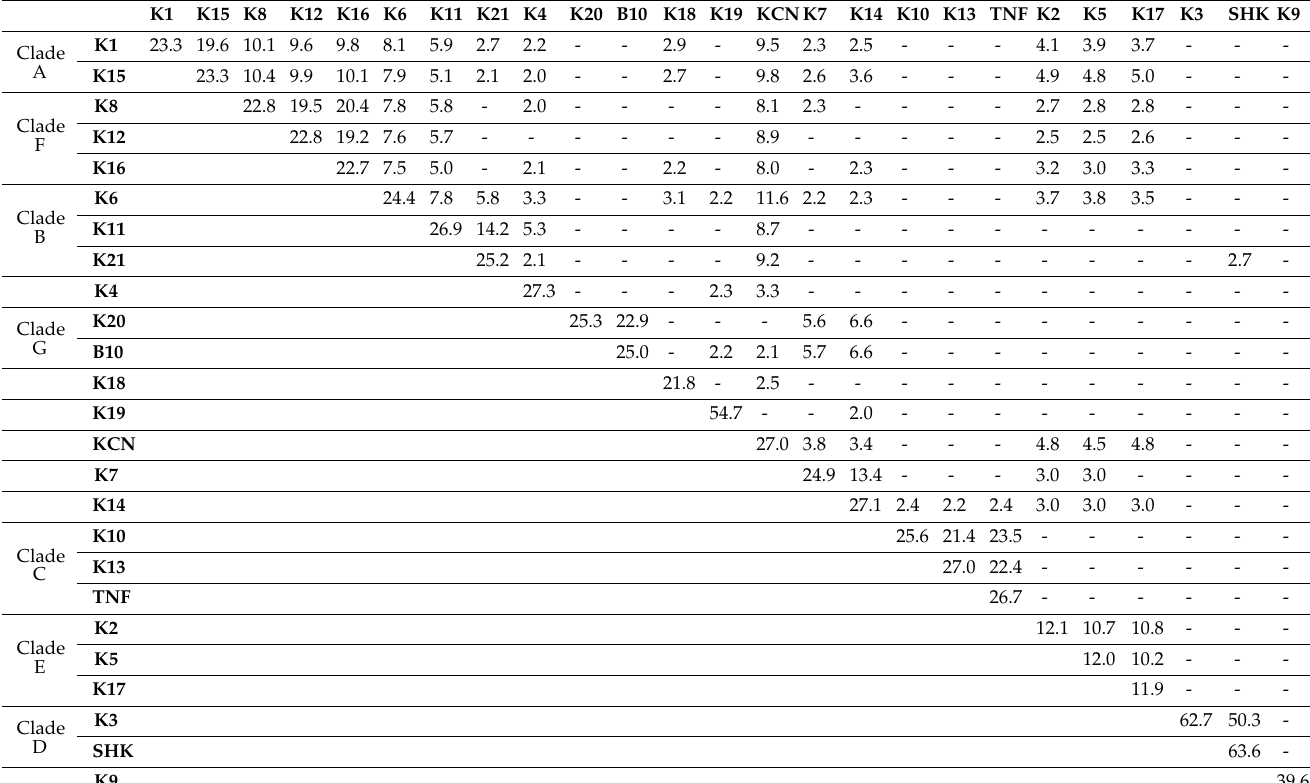
Table 3. Dali Z-score similarity matrix derived from the structural alignment of protein C-terminal domains. The clade definition is the one used in Figure S1. Dashes are reported for pairs for which Dali does not detect any significant similarity. The names of the proteins are abbreviated due to space